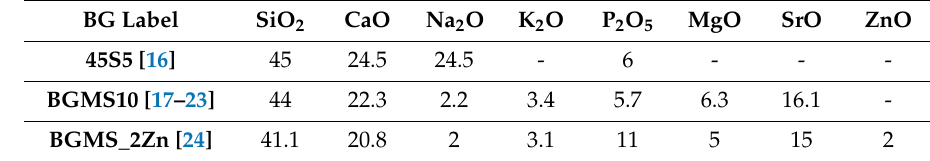
Table 1. Summary of bioactive glasses (BGs) compositions reported in wt%.